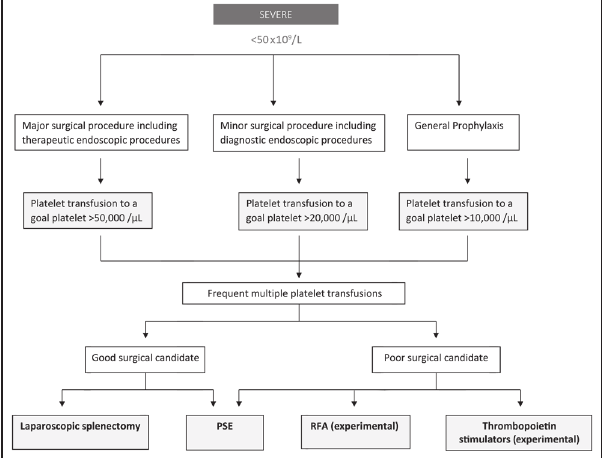
Figure 3) Cirrhosis and thrombocytopenia. PSE Partial splenic